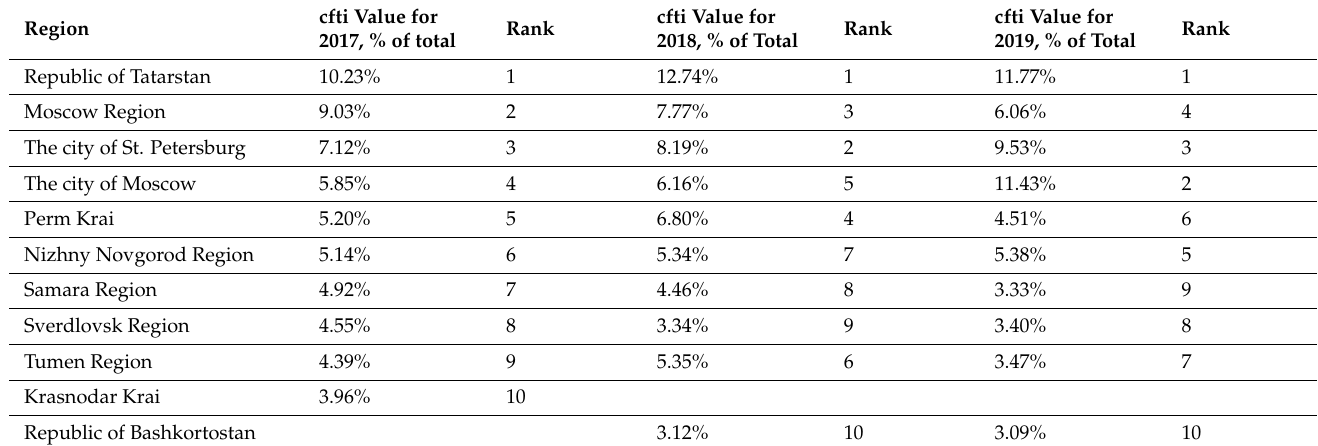
Table 11. Top 10 regions with the highest qing indicator value for